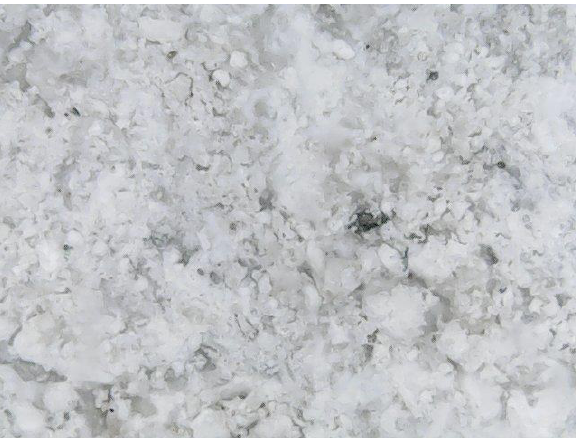
Figure 5. S2 sample series; magnification 500 X.